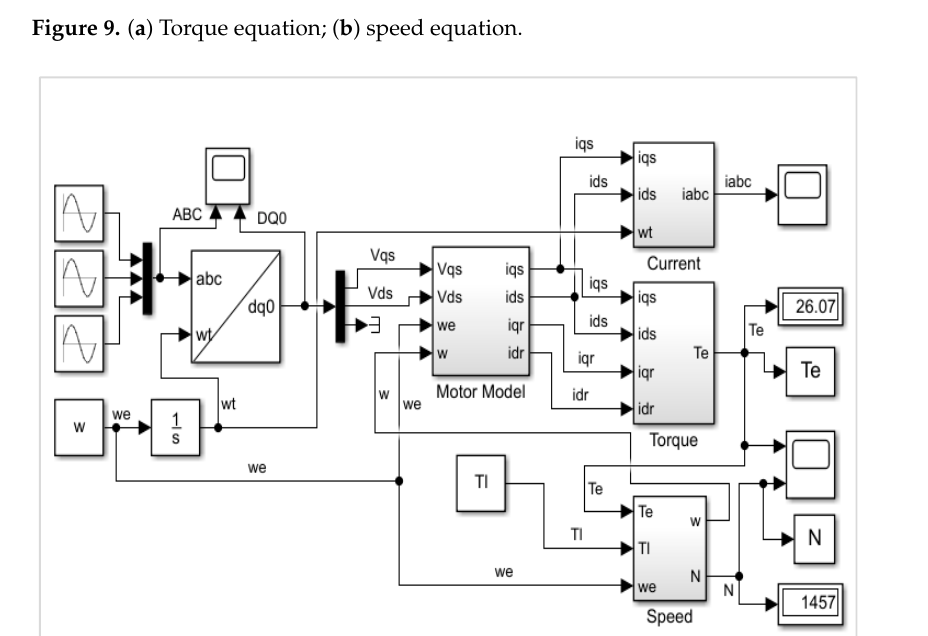
Figure 10. A complete model of the dynamic induction motor.